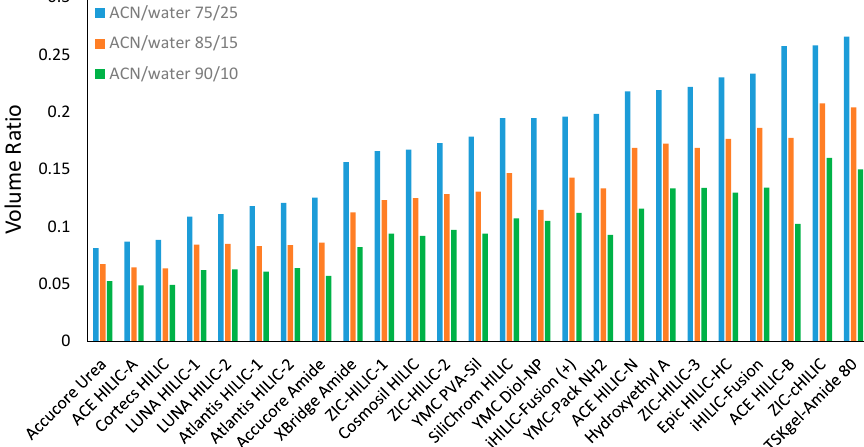
Figure 2. The volume ratio values ( β ) for the selected stationary phases in the mobile phase containing 75%, 85%, and 90% ACN. All the mobile phase contains 5 mM ammonium acetate. Column temperature is 25 °C.